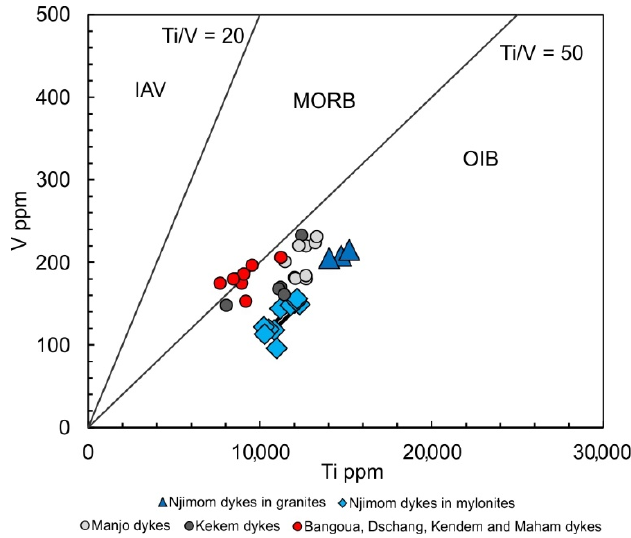
Figure 14. Ti-V diagram (after [31]) for Njimom